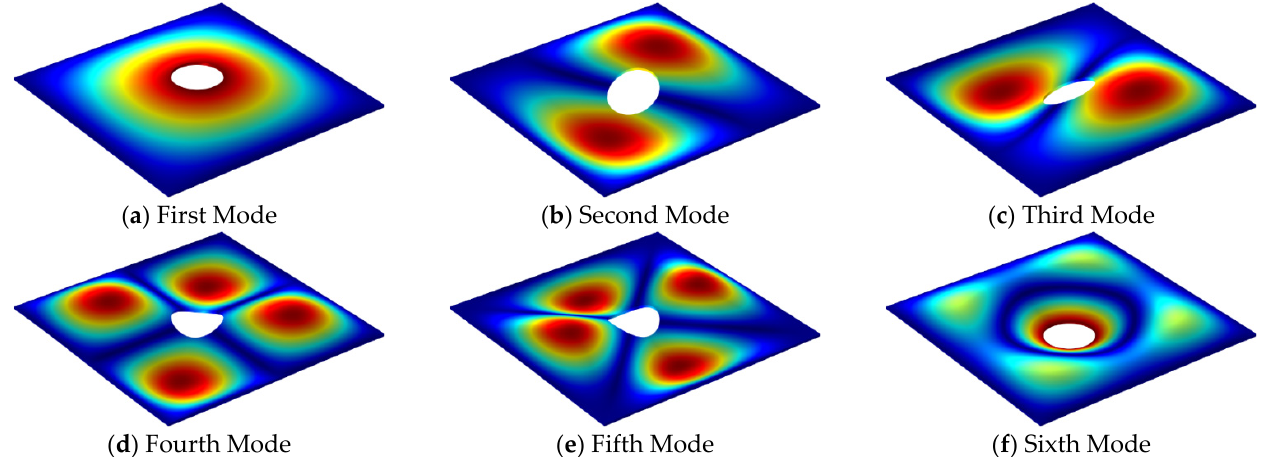
Figure 5. The first six mode shapes for SSSS-F FGMs square plate with central circular cutout ( h/a = 0.01, p = 1 ) .